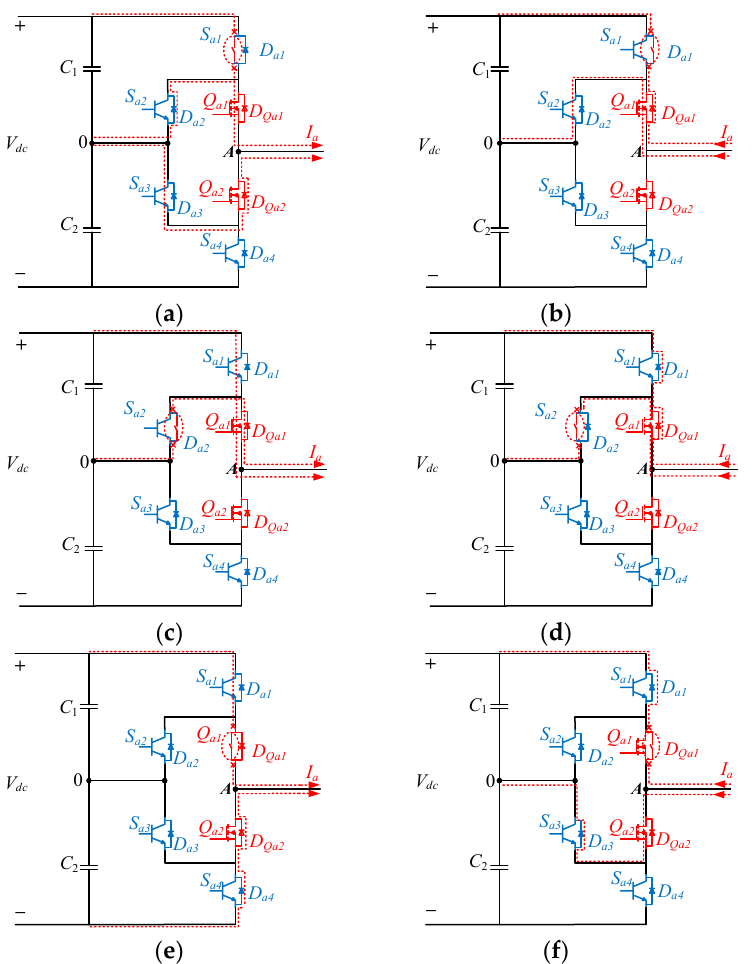
Figure 3. Open-circuit fault effects on the current paths at different switches ( a ) at S a1 / D a1 when I a > 0, ( b ) at S a1 / D a 1 when I a < 0, ( c ) at S a2 / D a2 when I a > 0, ( d ) at S a2 / D a2 when I a < 0, ( e ) at Q a1 / D Qa1 when I a > 0, ( f ) at Q a1 / D Qa1 when I a < 0.